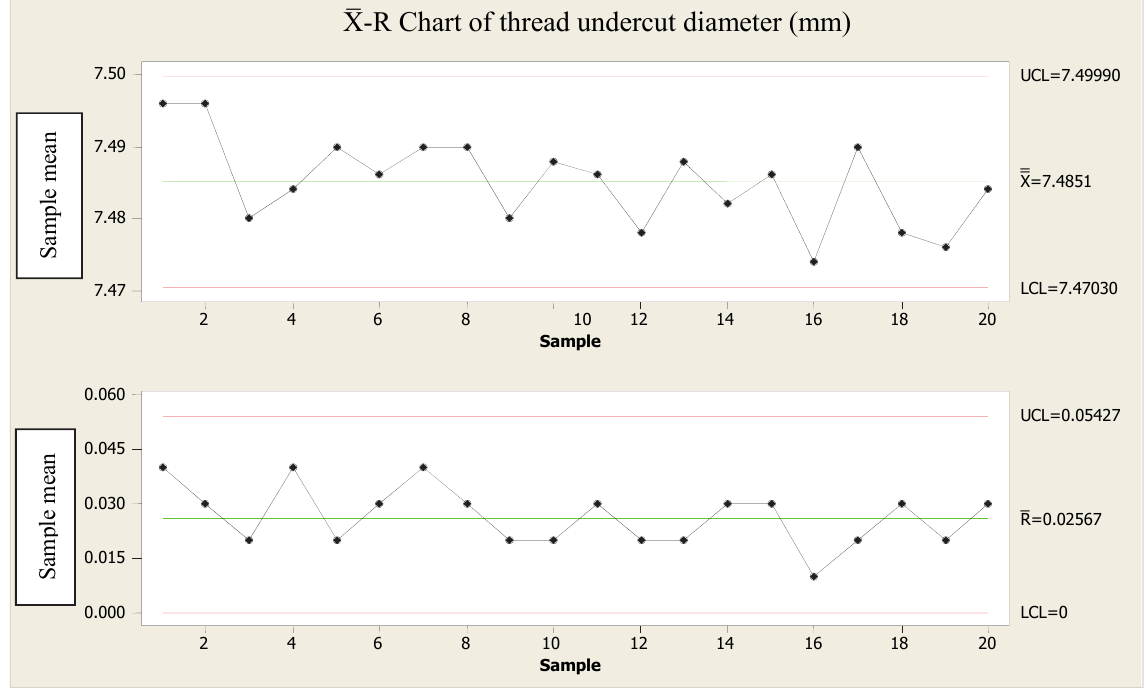
Fig. 9. X ̅ -R Chart of Thread Undercut Diameter (mm)